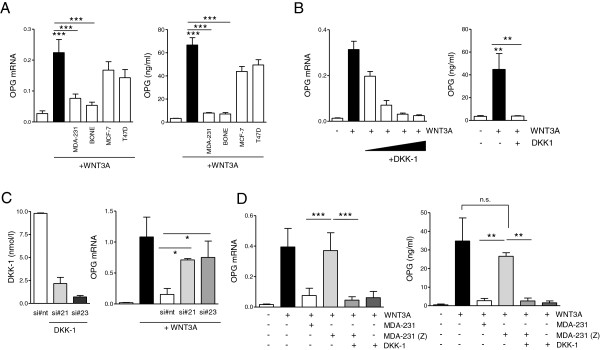
Dickkopf-1 inhibits WNT3A-induced osteoprotegerin production in C2C12 cells. (A) Supernatants of breast cancer cells were harvested after 48 hours. C2C12 cells were cultured in control medium (containing 50% control L-cell medium) or differentiated in WNT3A-containing media (50%) and concurrently treated with breast cancer supernatants (25%) or unconditioned control media (25%). C2C12 cells were treated for 48 hours and assessed for osteoprotegerin (OPG) expression and protein secretion. (B) C2C12 cells were differentiated with WNT3A media and exposed to increasing concentrations of recombinant Dickkopf-1 (DKK-1; 10, 50, 100 and 250 ng/ml). (C) DKK-1 was transiently knocked down in MDA-231 cells using two different single interfering RNAs (siRNAs). Knockdown was verified by quantifying DKK-1 levels secreted into the supernatant 48 hours after transfection. Supernatants of control siRNA and DKK-1 siRNA-treated cells were given to C2C12 cells during WNT3A-induced differentiation in the established ratios of 25% and 50%. OPG levels were determined after 48 hours of exposure. (D) C2C12 cells were exposed to supernatants of untreated or zoledronic acid-treated MDA-231 cells in the presence of WNT3A. To prevent potential direct effects of zoledronic acid on C2C12 cells, MDA-231 cells were preincubated with zoledronic acid for 24 hours, media were then replaced and zoledronic acid-free supernatants were harvested 48 hours later. Suppressed DKK-1 levels in the supernatant were confirmed by enzyme-linked immunosorbent assay (ELISA) prior to use. Results of ELISA and polymerase chain reaction data are presented as the mean ± standard deviation of three independent experiments. *P < 0.05; **P < 0.01; ***P < 0.001.